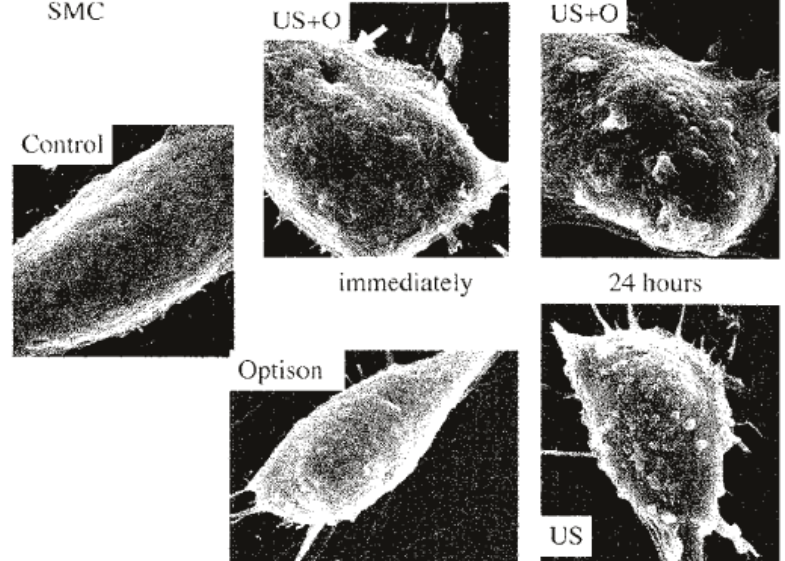
Figure 3. Electron microscope images of human skeletal muscles transfected with Optison MBs and pDNA with or without US. Micropores can be seen immediately following transfection (white arrow). (Reprinted from Taniyama et al. [43] with permission.)